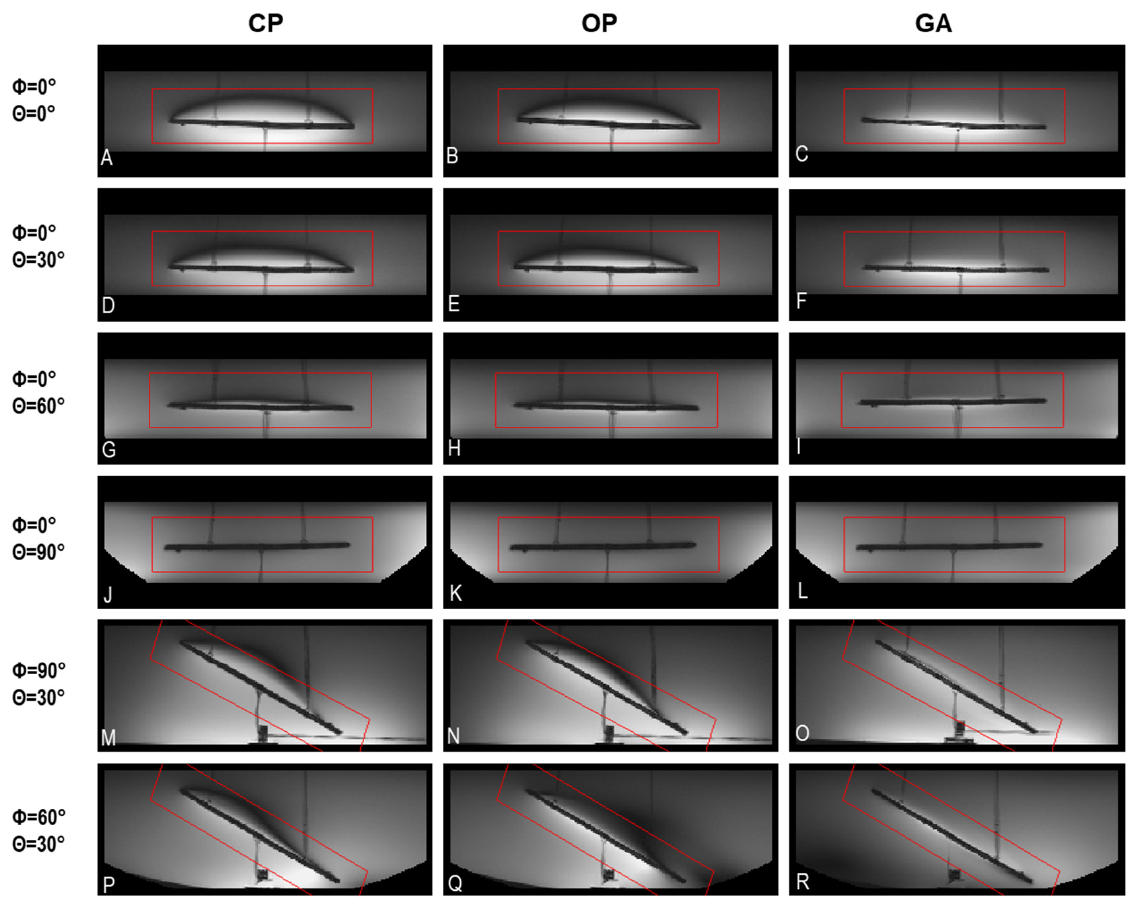
Figure 8. Minimum-intensity projections of worst-case 𝐵 (cid:2869)(cid:2878) artifacts obtained from 3D gradient-echo MRI in the vicinity of the implant using CP-, OP-, and GA-based transmission field shimming; ( A – R ) correspond to the excitation vector shown in Figure 7 for several implant orientations. The implant orientation is defined by using polar and azimuthal angles in spherical coordinates by con- sidering the origin of the coordinate system on the center of the implant. The ROI under investigation is indicated in